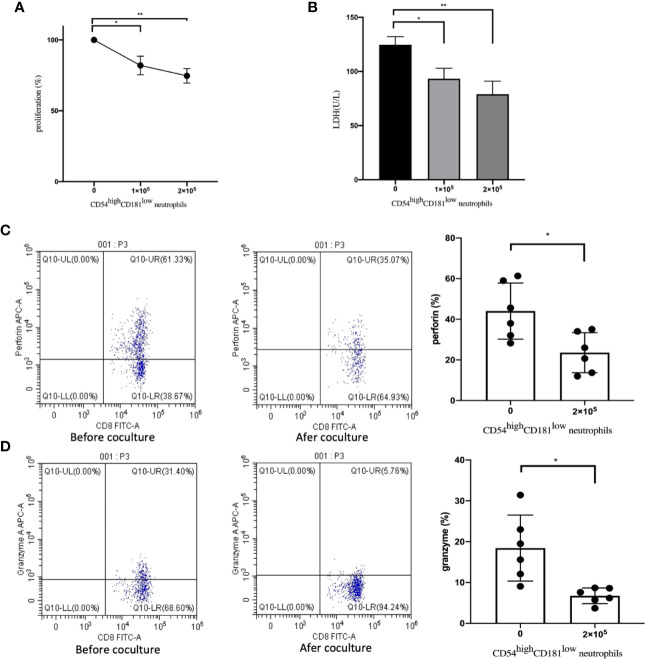
Impact of CD54highCD181low neutrophils from myelodysplastic syndromes (MDS) patients on T cells. (A) The dose-dependent suppressive activity of FACS-sorted CD54highCD181low neutrophils from MDS patients (n=6) was evaluated in coculture experiments with autologous T cells activated by means of anti-CD2, -CD3, and -CD28 microbeads. Proliferation of T cells was assessed after 5 days by CCK-8 assay and compared with stimulated T cells alone (set as 100% T-cell proliferation). (B) The levels of lactate dehydrogenase (LDH) in supernatant of coculture experiments with CD54highCD181low neutrophils, CD3+ T cells and effector cells. (C) The perforin of CD3+CD8+ T cells before and after coculture with CD54highCD181low neutrophils from the peripheral blood of MDS patients. (D) The granzyme B of CD3+CD8+ T cells before and after coculture with CD54highCD181low neutrophils from the peripheral blood of MDS patients. The bars represent the standard error of the mean. *P < 0.05; **P < 0.01.